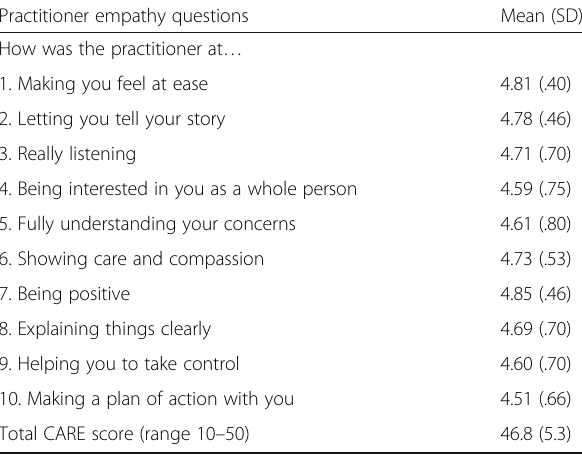
Table 4 Consultation and Relational Empathy (CARE) measure Practitioner empathy